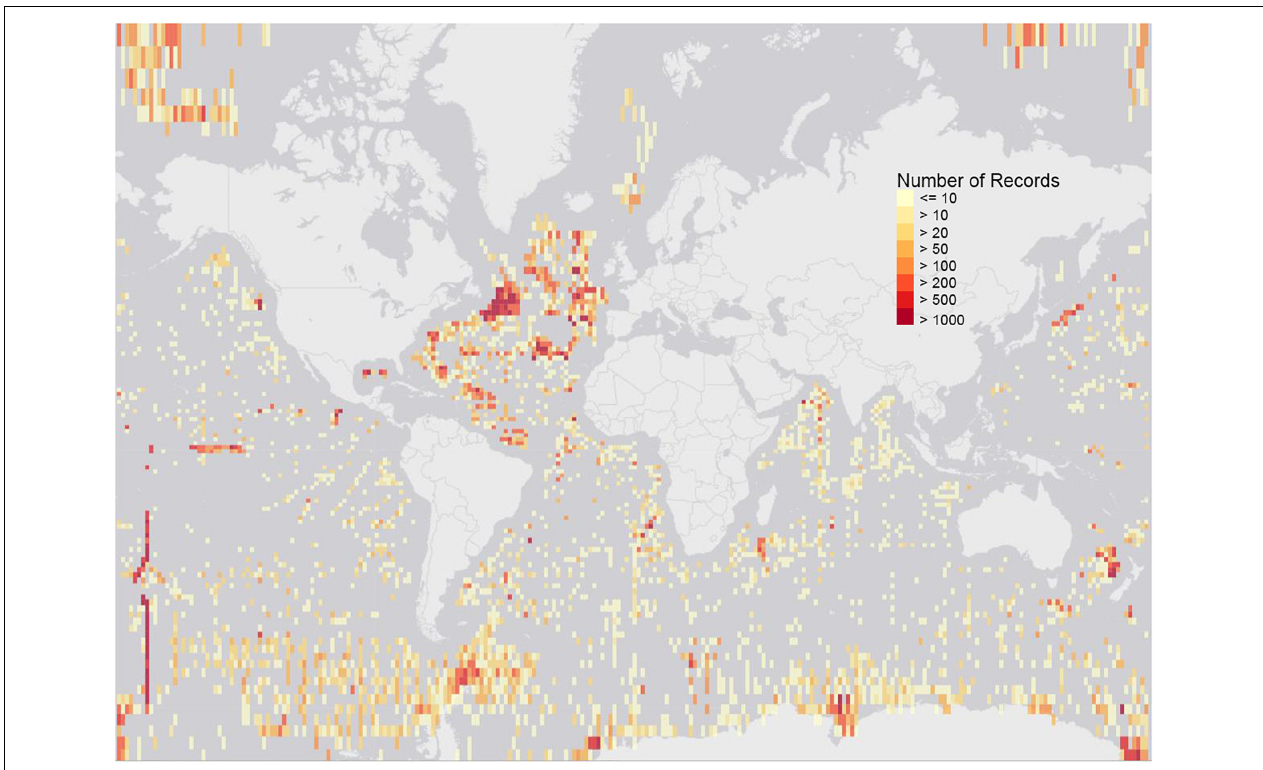
FIGURE 3 | Map of all OBIS records from ABNJ from depths of 500m and greater, 371,890 records of 10,437 species in total, observed between 1866 and 2018 (data at 12 May 2019). The dataset can be downloaded and viewed at